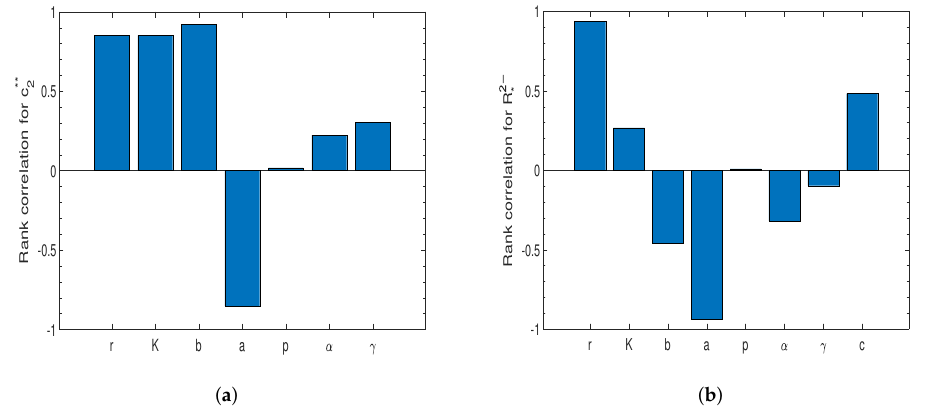
Figure 6. Partial rank correlation coefficients illustrating the dependence of c ∗∗ the system (2) on each parameter. The parameter values are listed in Table